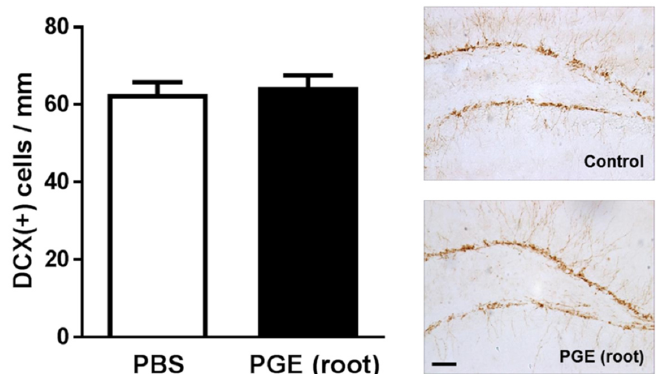
Figure 4. Immunohistochemical analysis using DCX antibody. DCX is a marker of neurogenesis, especially neuronal fate specification. The PGE (root)-administered group shows a similar number of DCX (+) cells per unit length compared to the control group. Values are the mean + SEM. Scale bar = 50 µm. PGE, Platycodon grandiflorus extract. DCX, doublecortin.